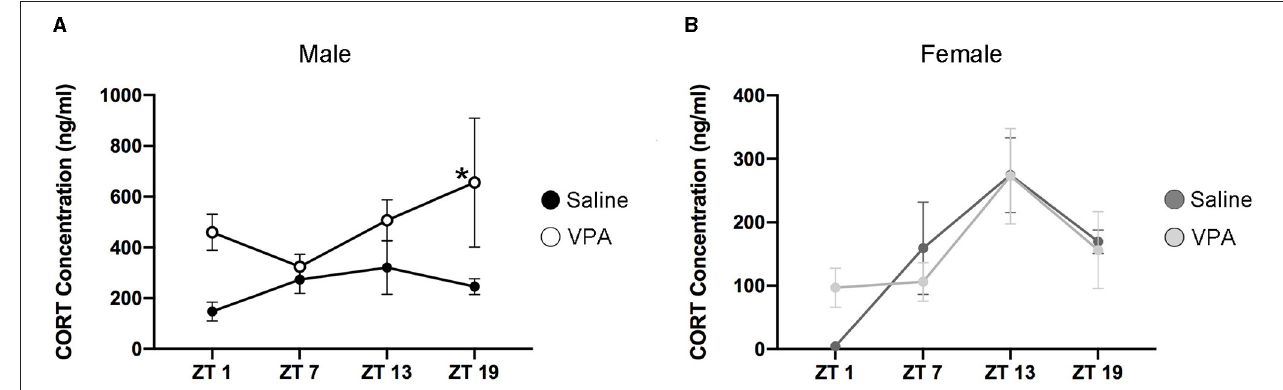
FIGURE 7 | Altered temporal secretion profiles of CORT in VPA-exposed animals. (A) Plasma CORT levels for saline and VPA-exposed males and (B) females, under standard 12:12 LD conditions, collected over a 24h period (ZT 1, 7, 13, 19, n = 2–3/time-point). In utero exposure to VPA alters secretion of CORT (ng/ml) in males, but not females [two-way ANOVA, significant main effect of treatment, F (1, 13) = 14.35, p = 0.0023]. Planned comparisons revealed a significant difference in CORT secretion at ZT 19 between groups (saline: M = 1,251, VPA: M = 3,281, p = 0.0321). Means ± SEM are shown. Data was analysed using a two-way ANOVA and a Bonferroni planned comparison of time points. * ≤